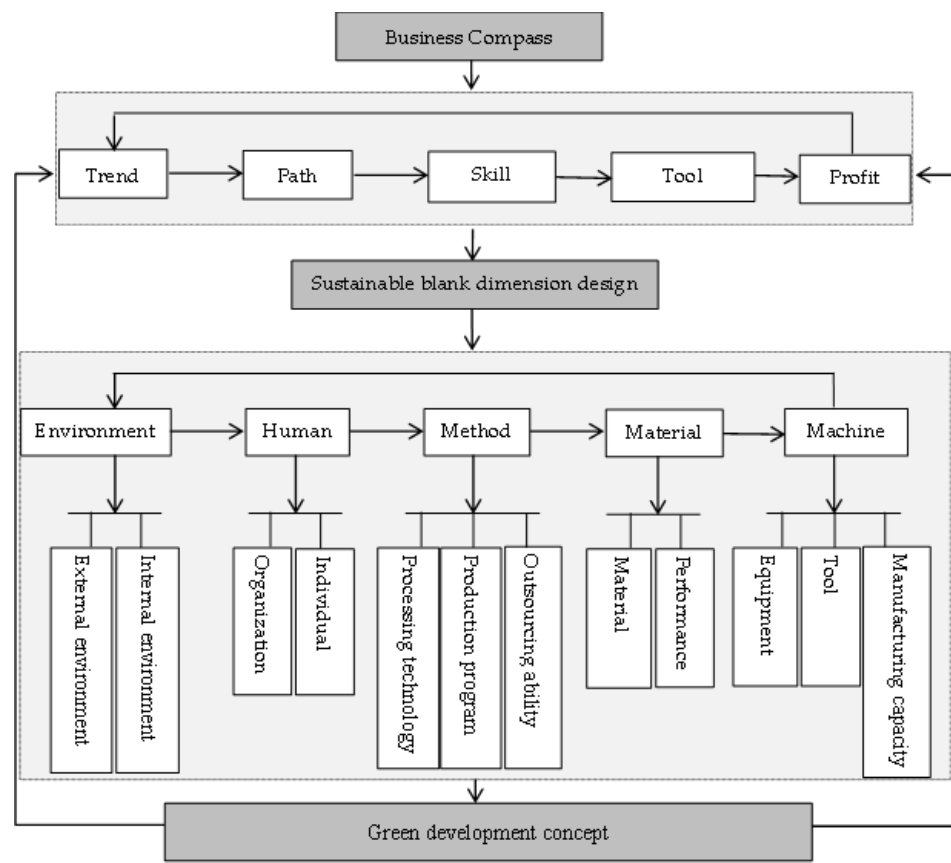
Figure 2. The framework for sustainable design of blank dimension.